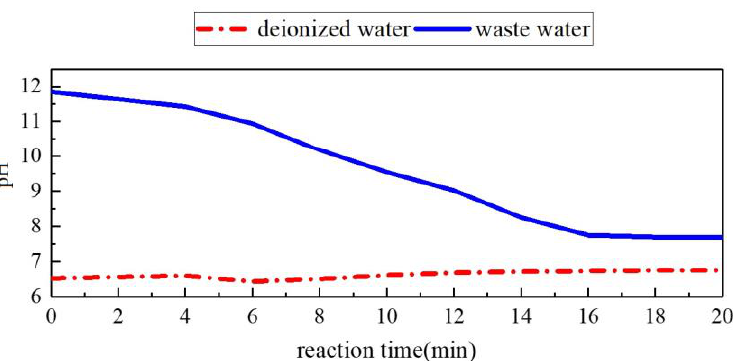
Figure 2. pH curve under the combined action of ozone (25 g·m − 3 ) and manganese dioxide as catalysts (6 g·L − 1 ).